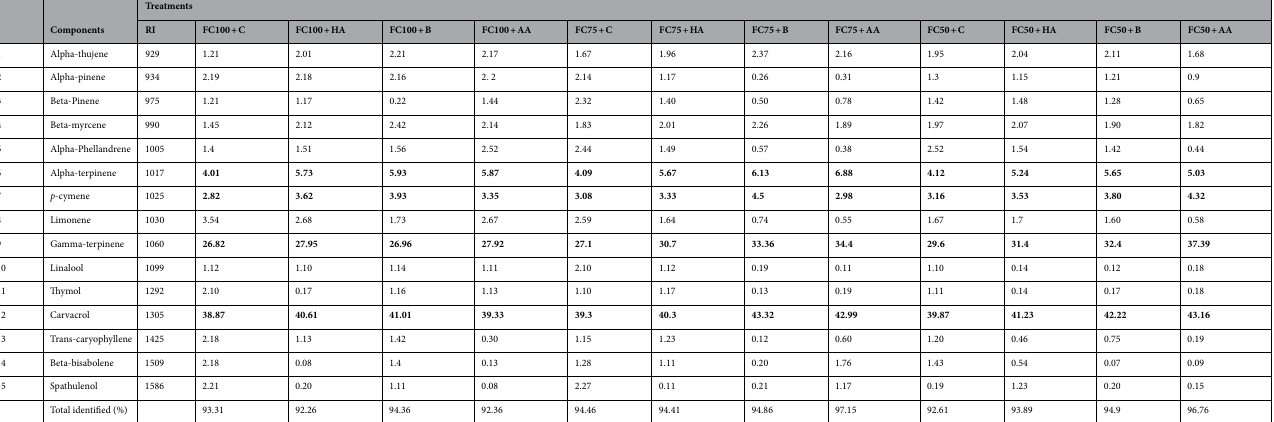
Table 5. Effect of irrigation regime and biofertilizer on essential oil compounds of savory (average of two years). Identification methods: MS, comparison of the mass spectrum with those of computer mass libraries Wiley, Adams, and NIST 08; RI, comparison of retention index with those reported in Adams and NIST 08; RI, linear retention indices on DB-5 MS column, experimentally determined using homolog series of n -alkanes Irrigation at 100% FC, 75% FC, and 50% FC, corresponding to full-irrigation, moderate water stress, and severe water stress, respectively, C control, HA humic acid, B bacterial, AA amino acid. Main components are shown in